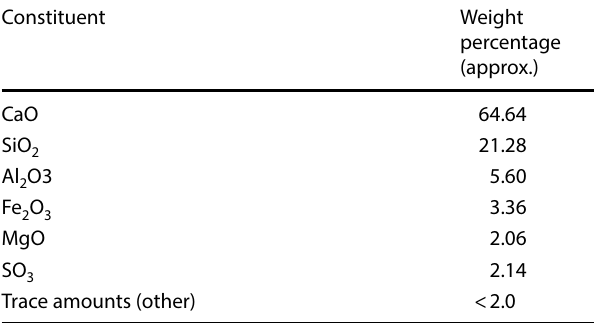
Table 1 Composition of construction grade ordinary Portland cement type I/II by (wt%) [18]